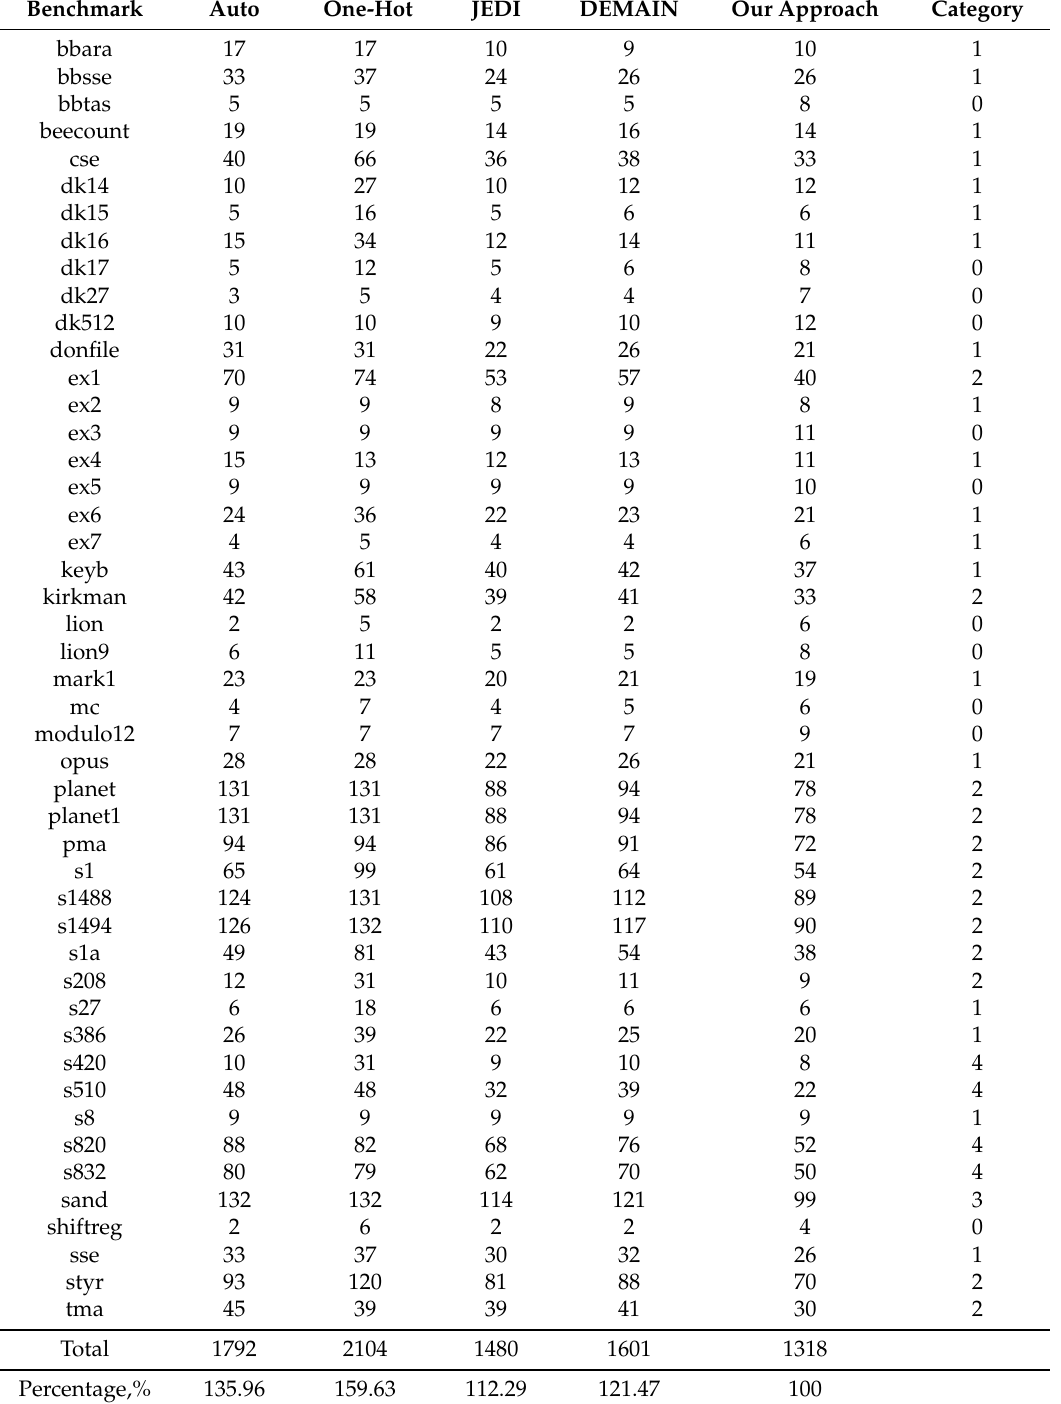
Table 5. Experimental results (the number of